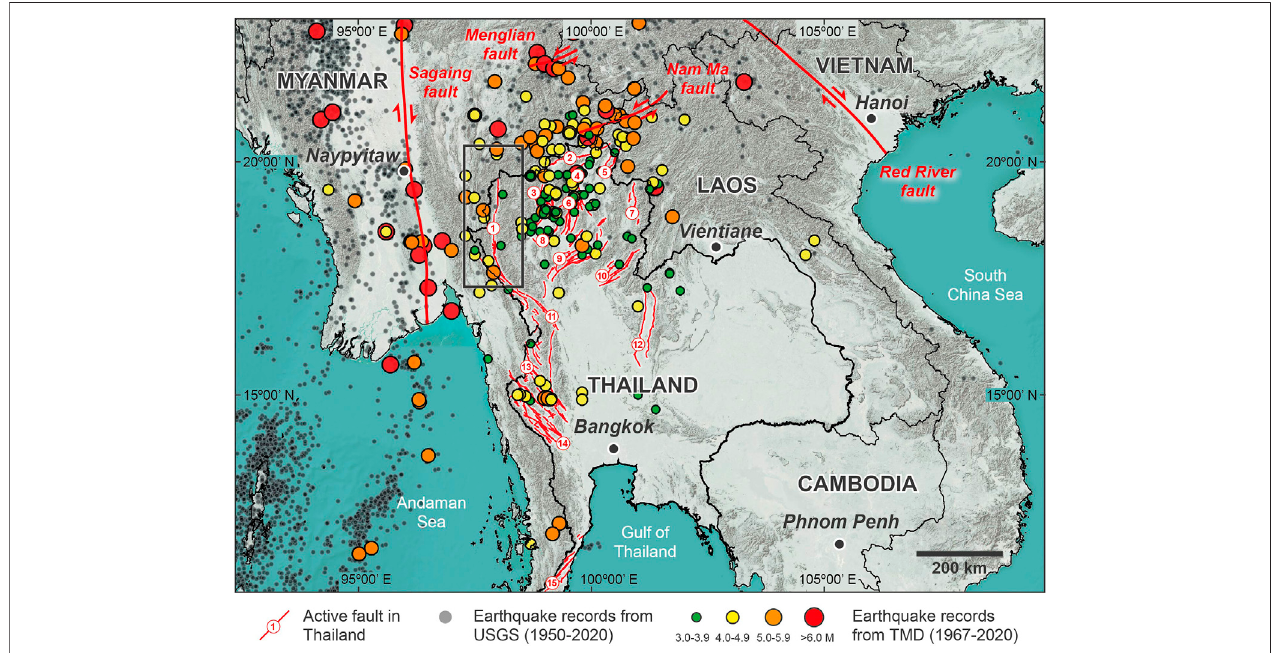
FIGURE 1 | Major active faults in Thailand and adjacent regions (modi fi ed from Department of Mineral Resources (2019) and Wang et al. (2014)) and epicentral distributionfrom 1967to2021(USGS, 2021;Thai MeteorologicalDepartment, 2022).Faultname no. 1:MaeHong SonFault; 2: MaeChan Fault; 3:Wiang Heang Fault; 4: MaeLaoFault; 5: MaeIng Fault; 6:Phayao Fault; 7:PuaFault; 8: MaeThaFault; 9: Thoen Fault; 10:Uttaradit Fault; 11: Moei Fault; 12:PetchabunFault; 13:SriSawat Fault; 14: Three Pagodas Fault; 15: Ranog Fault. The rectangle shows the location of the study area.